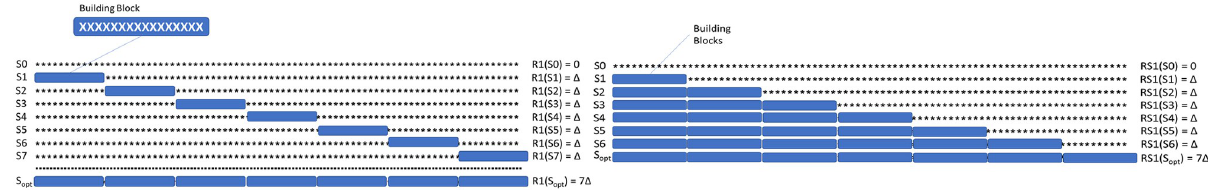
Fig 11. Schemes of the RR (left) and RS (right)